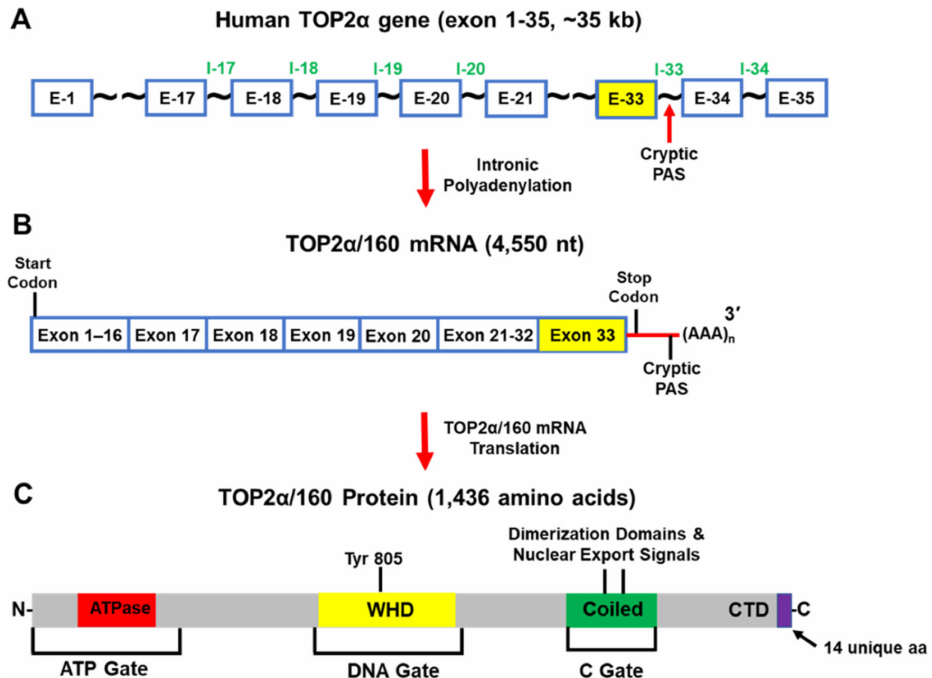
Figure 6. Schematic representation of the human TOP2 α gene, TOP2 α /160 mRNA, and TOP2 α /160 isoform. ( A ) The human TOP2 α gene comprises of 35 exons and spans ~35 kb. ( B ) When Intron 33 IPA occurs, the predominate TOP2 α mRNA transcript is 4550 nucleotides long. ( C ) This mRNA encodes a TOP2 α isoform of 1436 aa, denoted TOP2 α /160. The truncated TOP2 α /160 isoform is missing the nuclear localization signal (NLS 1454-1497) and is found predominantly in the cytoplasm. Therefore, the number of TOP2 α /170 DNA covalent cleavage complexes are reduced and drug resistance